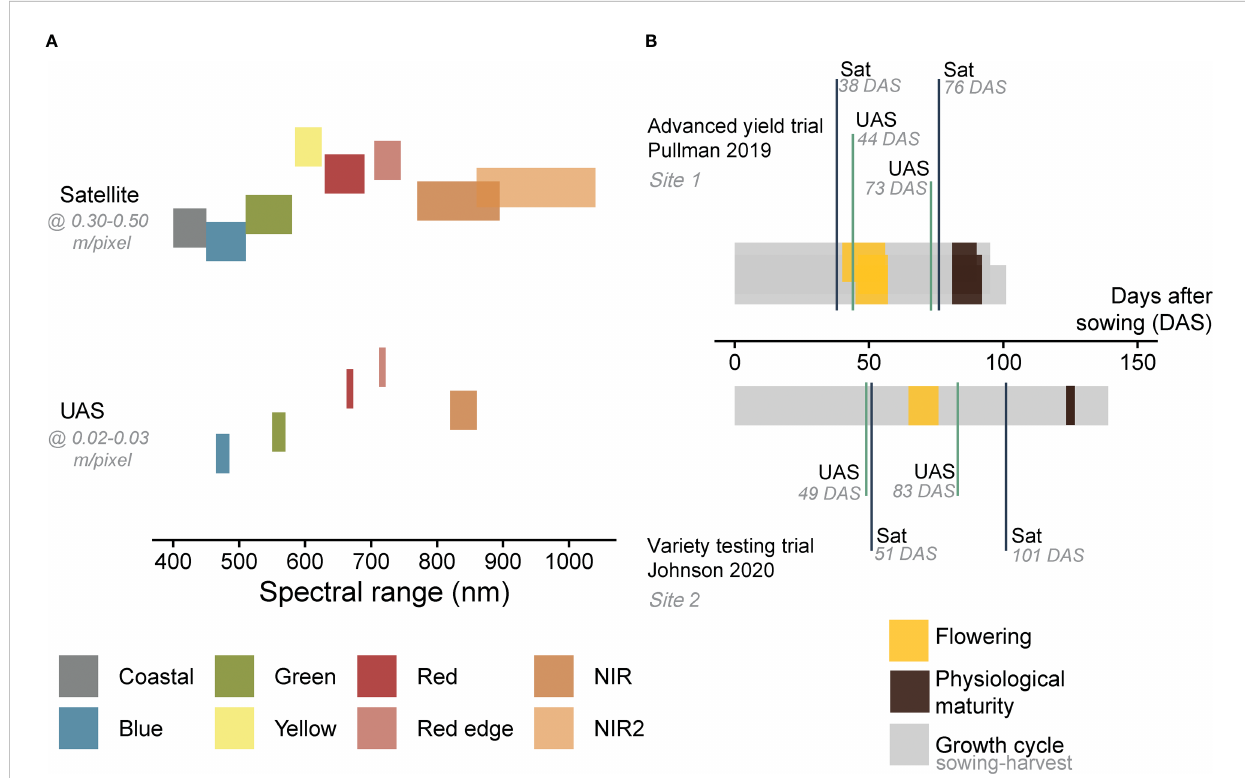
FIGURE 2 Spectral range of satellite and UAS multispectral imagery acquired in this study (A) . The data acquisition time points of remote sensing data (B) . Details about spectral resolution and acquisition dates are summarized in Supplementary Materials Table 1. DAS refers to days after